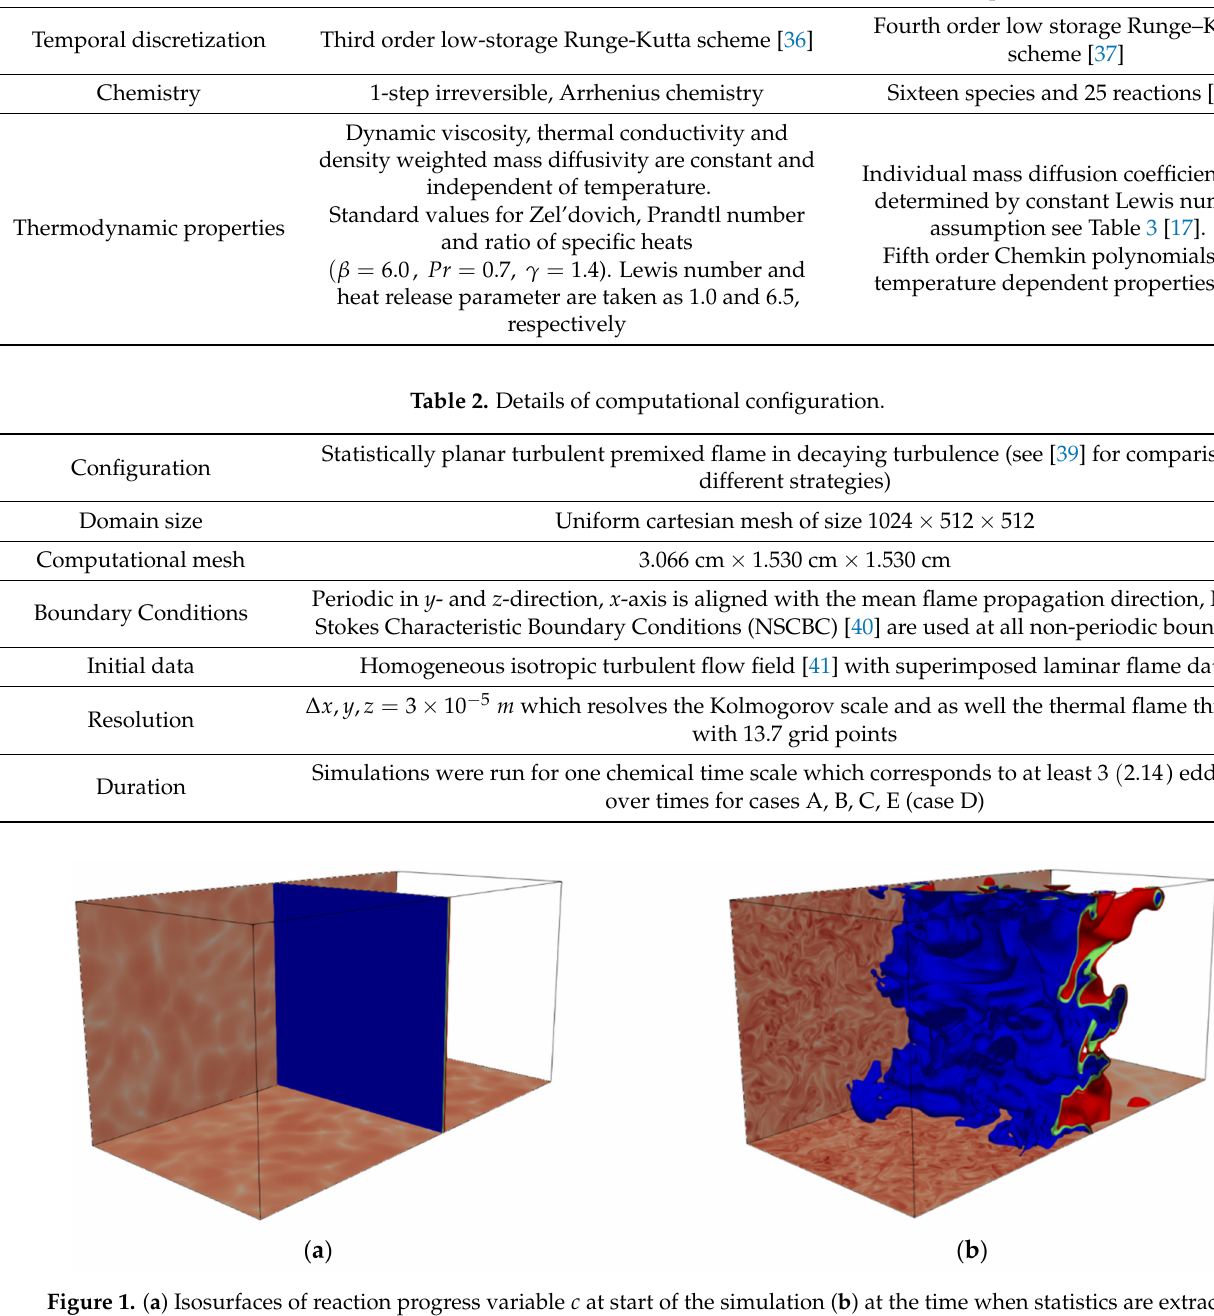
Figure 1. ( a ) Isosurfaces of reaction progress variable c at start of the simulation ( b ) at the time when statistics are extracted exemplarily for case DD. Blue, green and red colour represent reaction progress variable values of c = 0.1, c = 0.5 and c = 0.9 respectively. The vorticity magnitude is shown on the x − y and x − z plane on a logarithmic scale where red (blue) represents high (low) vorticity